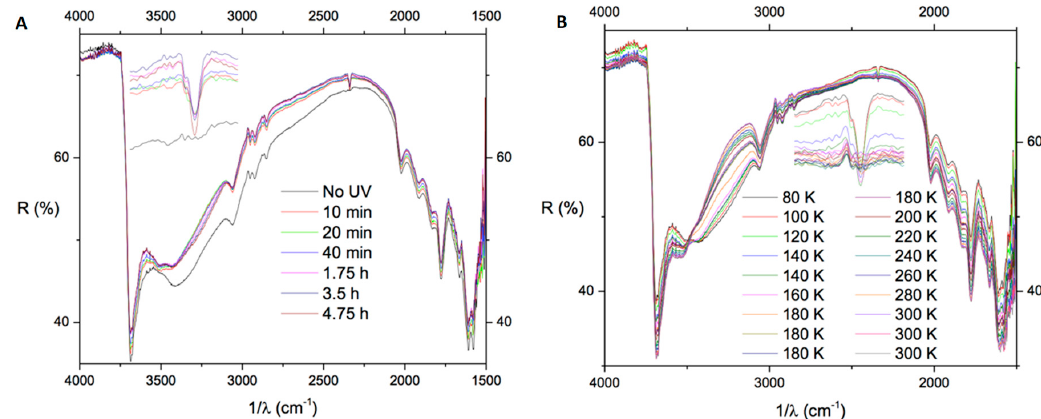
Figure 5. Diffuse reflectance infrared Fourier transform spectroscopy (DRIFTS) analysis of 1,8-dihydroxynaphthalene (1,8-DHN) adsorbed on forsterite during UV irradiation at 80 K ( A ) and during heating (from 80 to 300 K) after UV irradiation ( B ). Inset: magnification of the peak at 2340 cm − 1 due to CO 2 stretching.